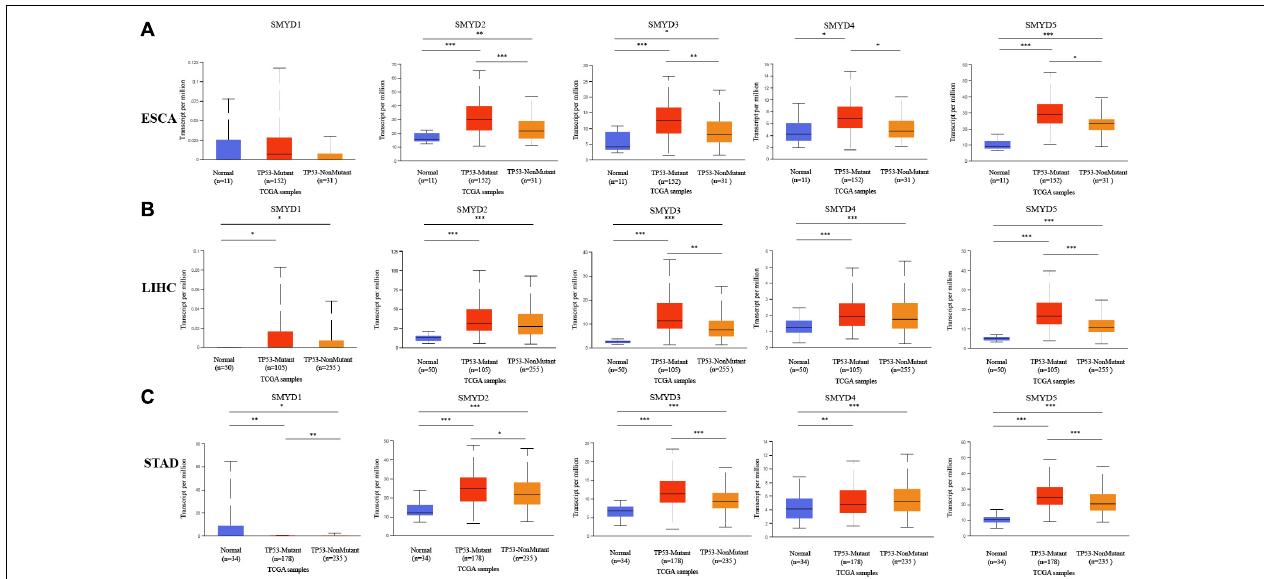
FIGURE 3 | The relationship between mRNA expression levels of SMYD family members and TP53 mutation in ESCA, LIHC, STAD (mutation: red, non-mutation: orange), and normal tissues of esophagus, liver, and stomach (blue) (UALCAN) (A–C) ( ∗ P < 0.05, ∗∗ P < 0.01, ∗∗∗ P <